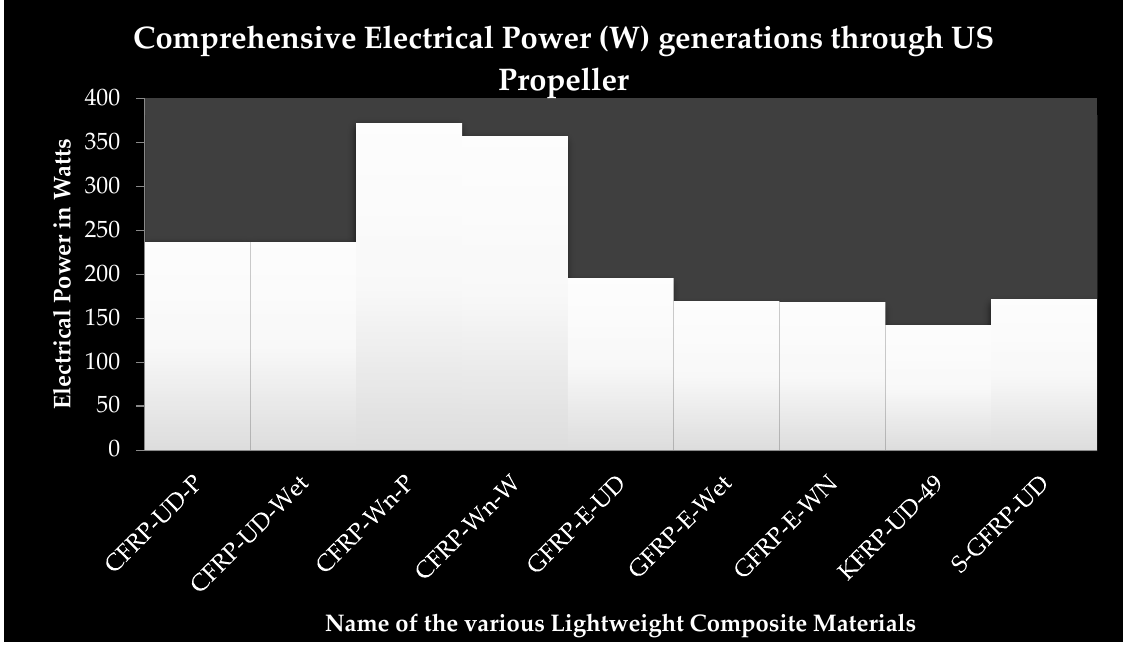
Figure 52. Comprehensive Electricity generation level of various lightweight composite materials.